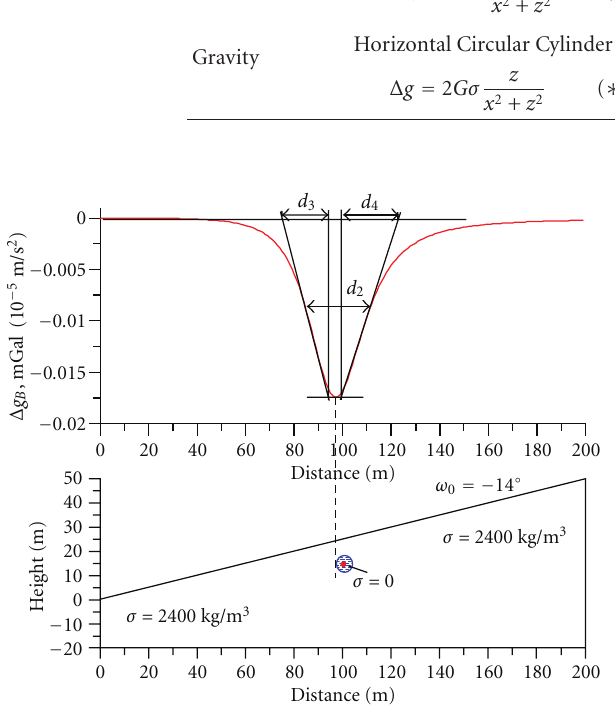
Figure 1: Quantitative analysis of gravity anomaly on inclined profile from a buried sphere.